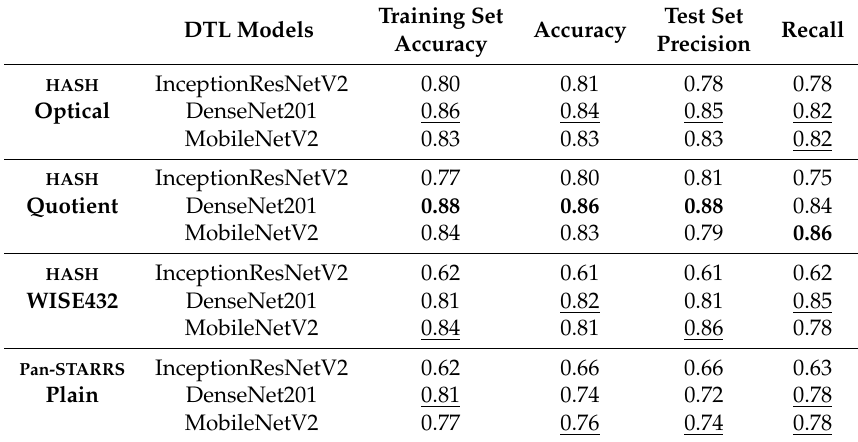
Table 7. The trained model evaluation results for True and Rejected PNe Classification from HASH DB and Pan-STARRS. The values are the average accuracy, precision and recall for both True PNe and Rejected